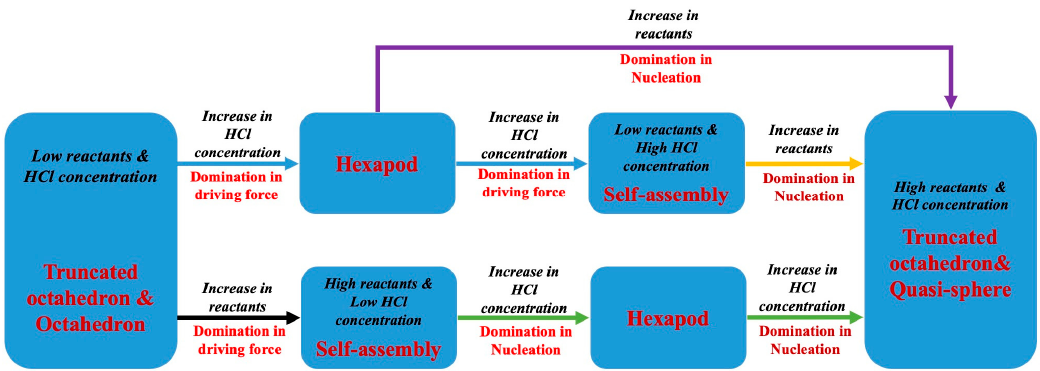
Figure 5. The summary flowchart of the crystal morphologies and synthesis conditions.